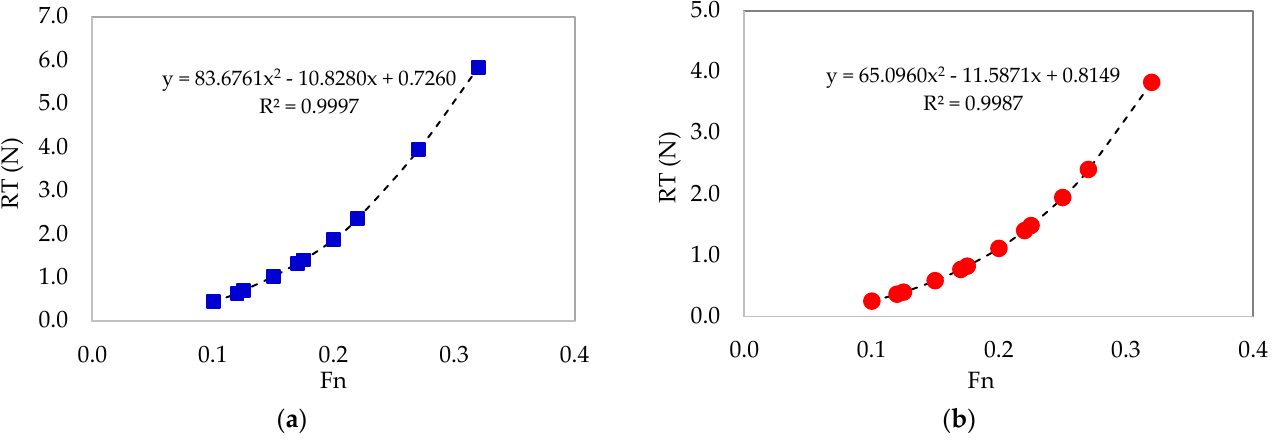
Figure 16. Statistical measure 𝑅 (cid:2870) for total resistance for amphibious vehicles: ( a ) w/caterpillars, ( b ) w/o caterpillars.